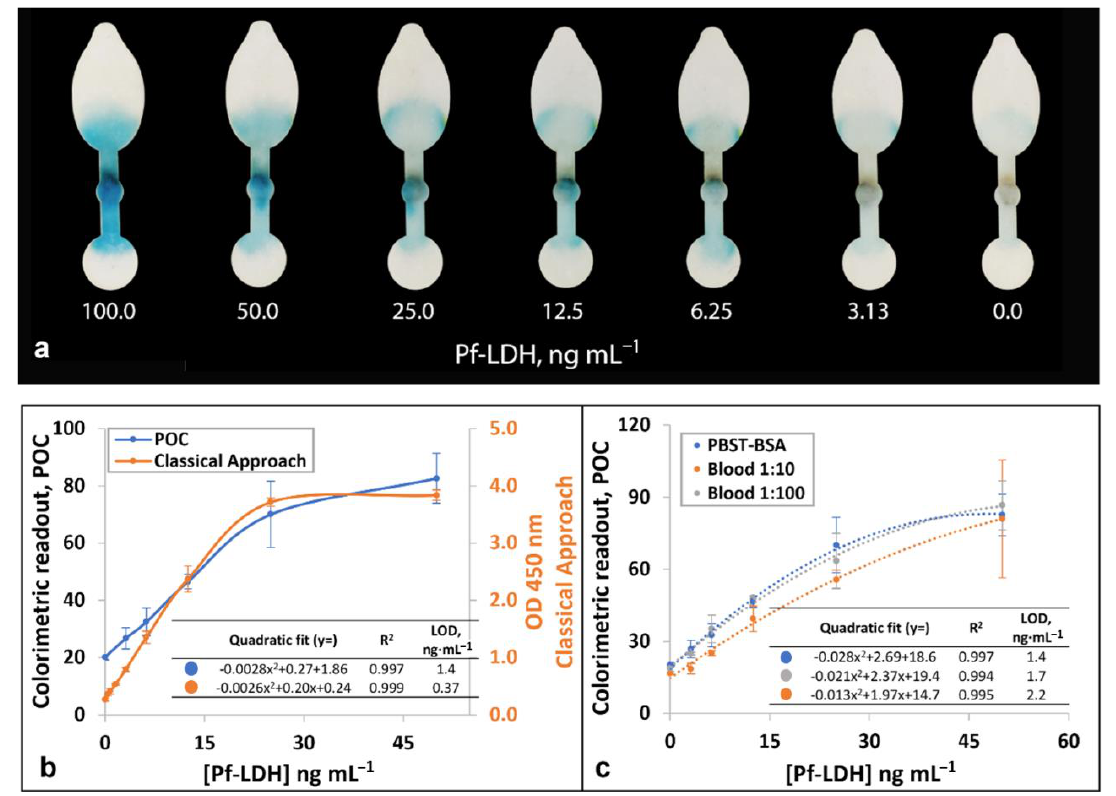
Figure 4. Signals registered in the paper-based magneto-immunoassay for different concentrations of Pf-LDH. ( a ) Photographs of the µPADs and results of semi-quantitative interpretation (Pf-LDH in PBST-BSA). ( b ) Signals obtained for the magneto-immunoassay carried in tubes using an ELISA reader (classical approach) and the µPAD using a smartphone and ImageJ (n = 4; Figure S7). ( c ) Signals registered in the µPAD for Pf-LDH spiked in PBST-BSA or lysed blood (1:10 and 1:100 in PBST-BSA).